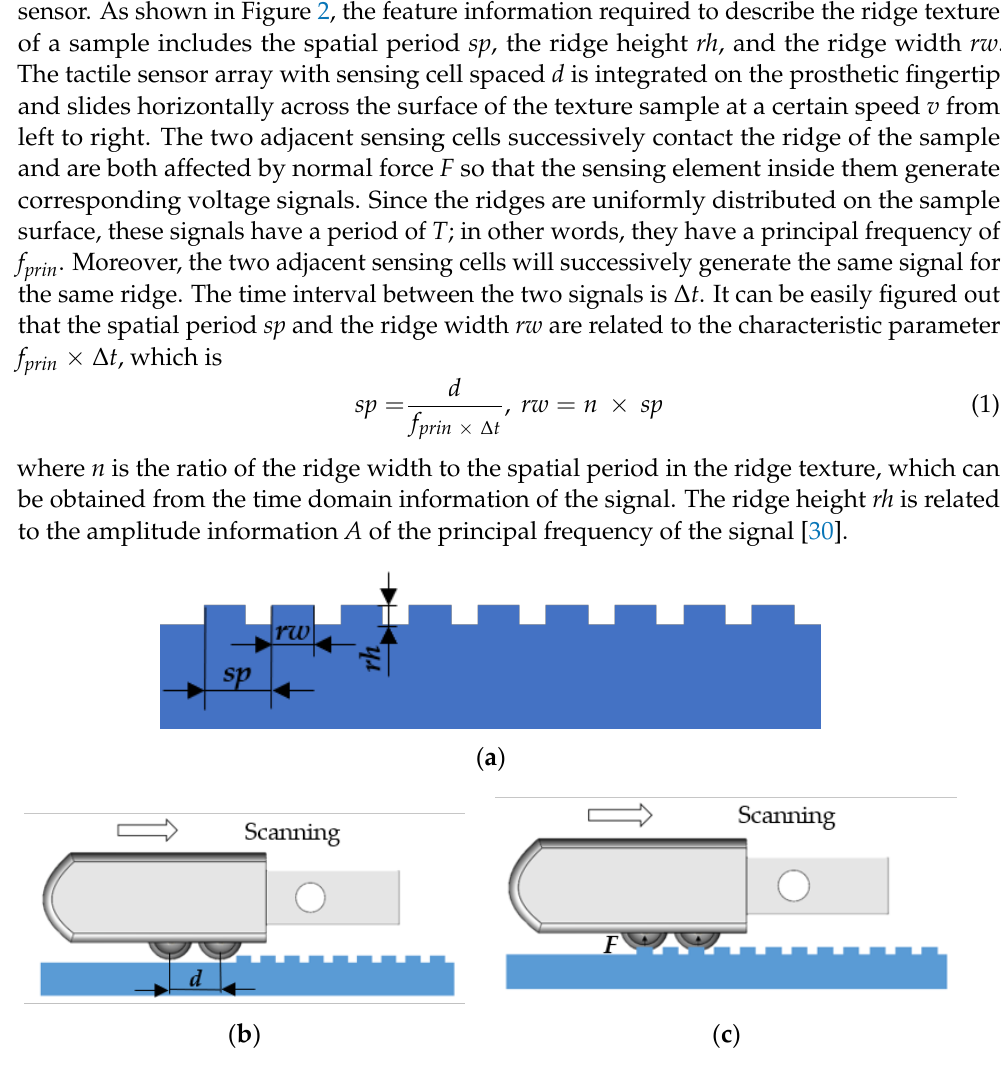
diagram of sensor fabrication process.